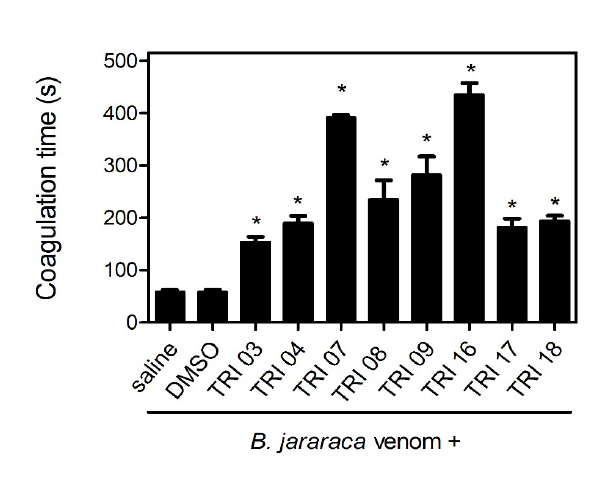
FIGURE 1 - Effect of the derivatives on coagulation time of B. jararaca